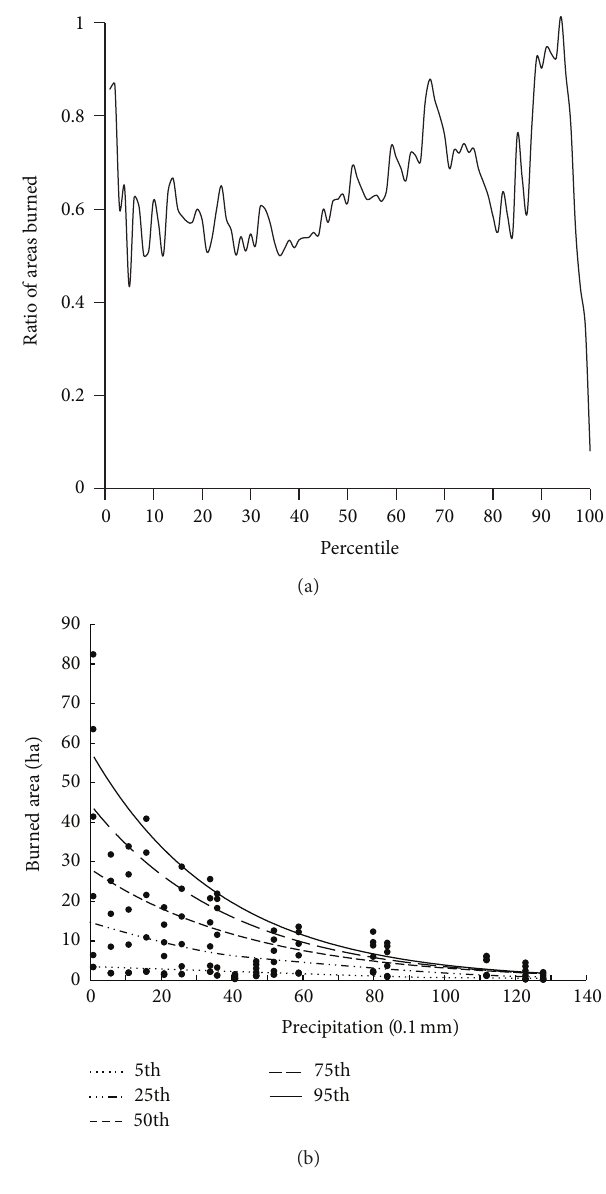
Figure 3: Ratio of the percentiles of burned area with precipitation versuswithoutprecipitationonadayofafire(a)andtherelationship between burned area and precipitation (b). Panel (b) shows the change of the percentile (5th, 25th, 50th, 75th, and 95th) lines of burned area generated by quantile regression model (1) with the rainfall amount on a day of